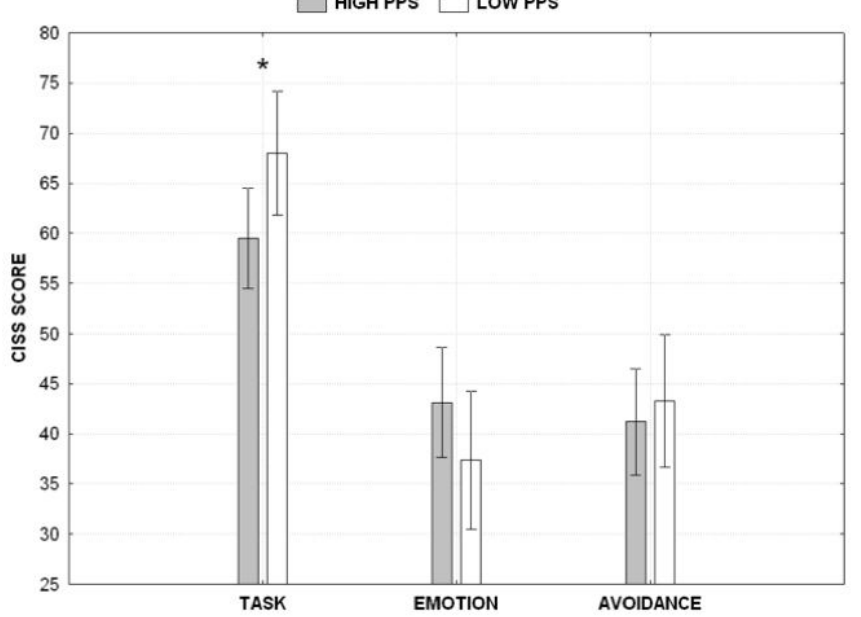
Figure 4. CISS score separately per scale (task-oriented, emotion-oriented, avoidance-oriented) and category of subjects. The asterisk denotes a statistically significant difference. Vertical bars denote 0.95 confidence